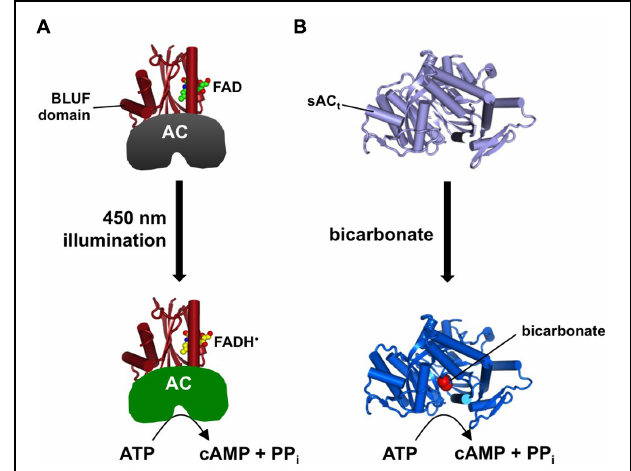
FIGURE 2 | Tools for triggering cAMP elevation. (A) Illustration of Beggiatoa PAC (bPAC) demonstrating how light illumination of the BLUF domain is coupled to activation of AC activity. (B) A truncated version of soluble AC (sAC t ) responds to elevated bicarbonate by catalyzing cAMP